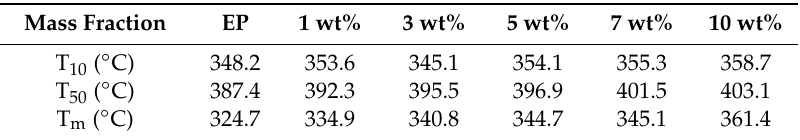
Figure 4. Thermogravimetric Analysis-Di ff erential Scanning Calorimetry (TG-DSC) curve of Al 2 O 3 -NWs / epoxy resin composites with di ff erent mass ratios.( a ) EP; ( b ) 1 wt%; ( c ) 3 wt%; ( d ) 5 wt%; ( e ) 7 wt%; and ( f ) 10 wt%. Table 1. TG-DSC test data of the pure epoxy resin and Al 2 O 3 -NWs / epoxy resin composites with di ff erent mass ratios.